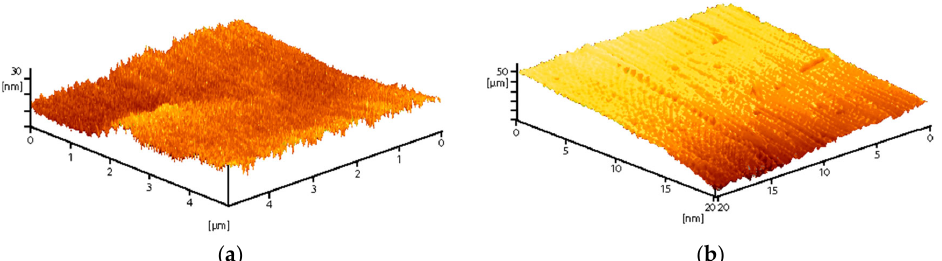
Figure 3. Images of the surface of a composite material obtained using atomic force microscopy with different resolutions ( a ) high, ( b ) low.